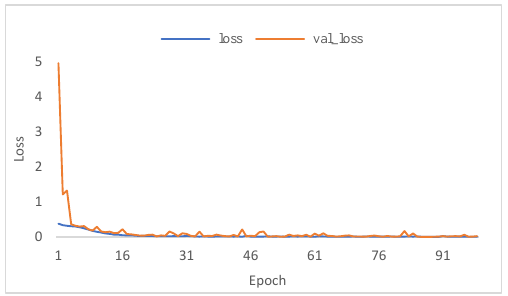
Figure 8. BFPC-Net training set and validation set losses. Table 3. Comparison of different algorithms